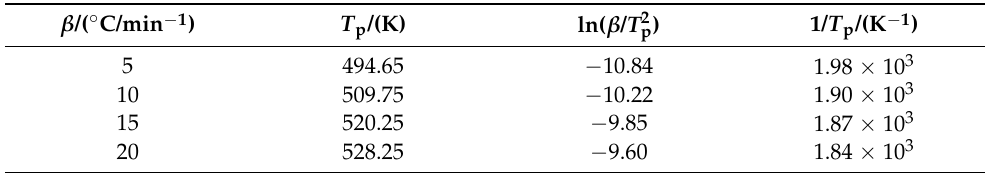
Figure 6. The DSC curves of BCPD/10 wt.% APPH at different heating rates. Table 2. ln( β / T 2 p ), ln β and 1/ T p at different heating rates. ), lnβ and 1/ T p at different heating rates. Table 2. ln(β/ T 2 p